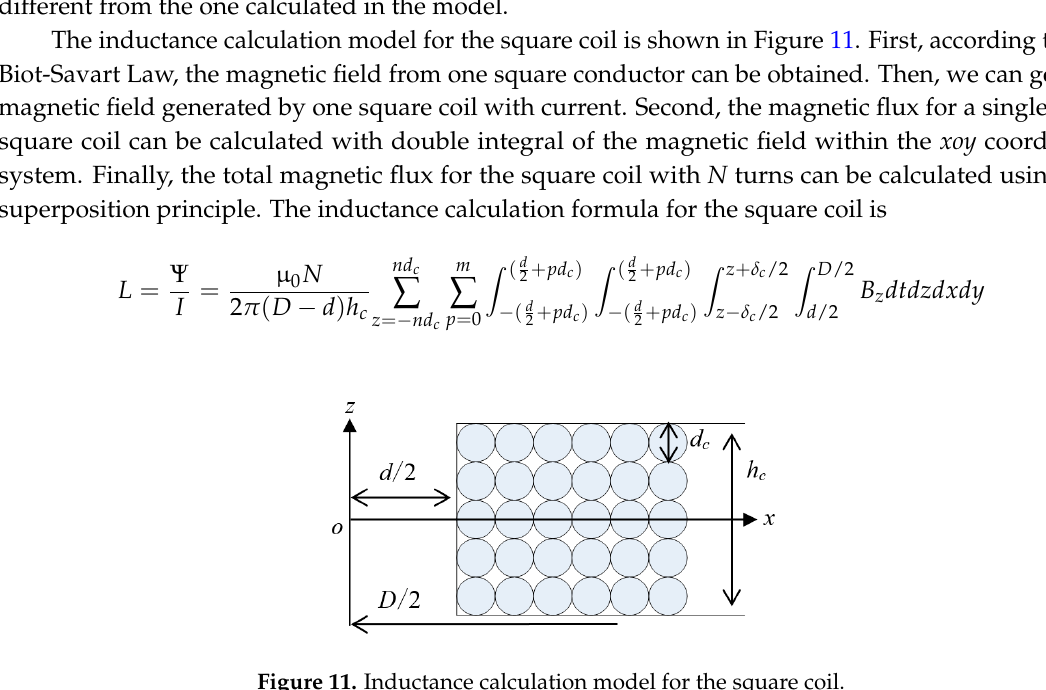
‐ Figure 12. Planar motor force experimental system. (DC: Direct Current)